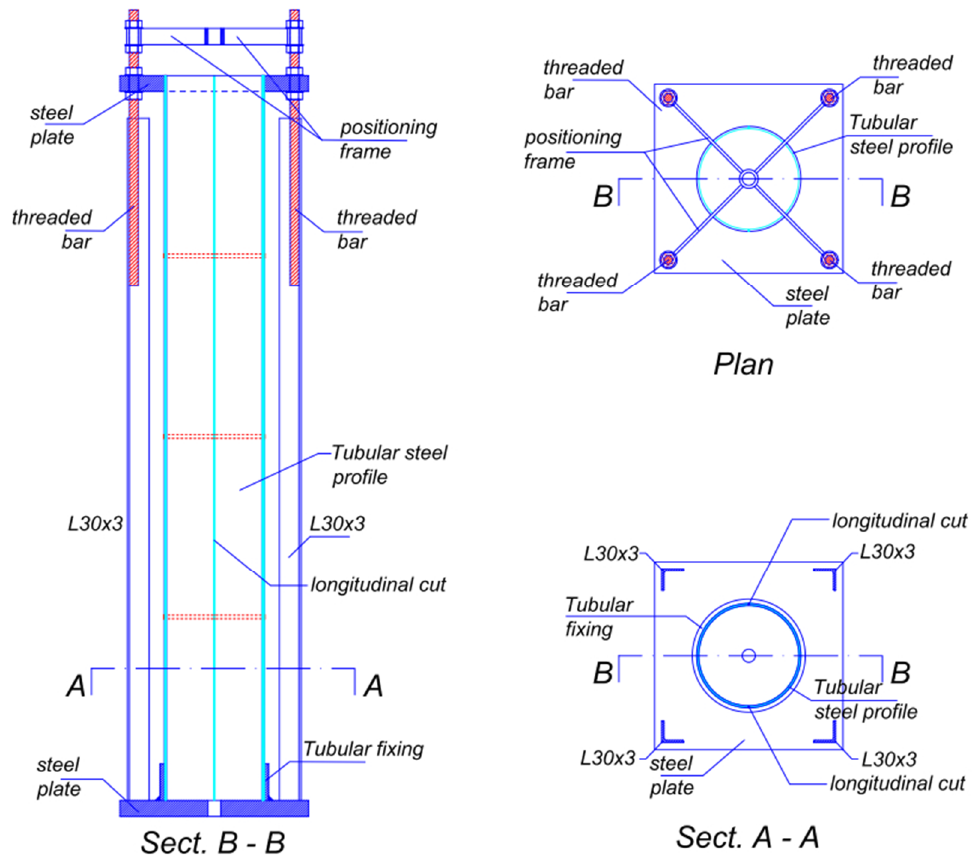
Figure 7. Special formworks used to prepare the cylindrical specimens.